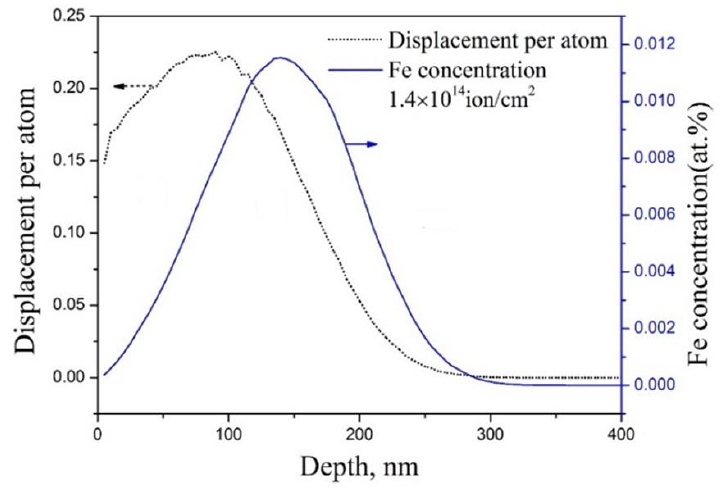
Figure 2 . Depth profile of displacement damage and Fe + concentration in the steels irradiated by 400 keV Fe + with a fluence of 1.4 × 10 14 ions/cm 2 calculated by SRIM 2008 software (quick mode).